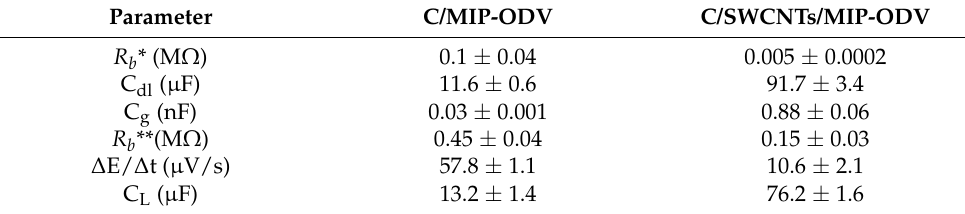
Figure 4. EIS and chronopotentiometric measurements for ODV membrane-based sensors. (( A ) C/MIP-ODV, ( B ) C/SWCNTs/MIP-ODV). Table 4. Electrochemical impedance and chronopotentiometric features in absence and presence of